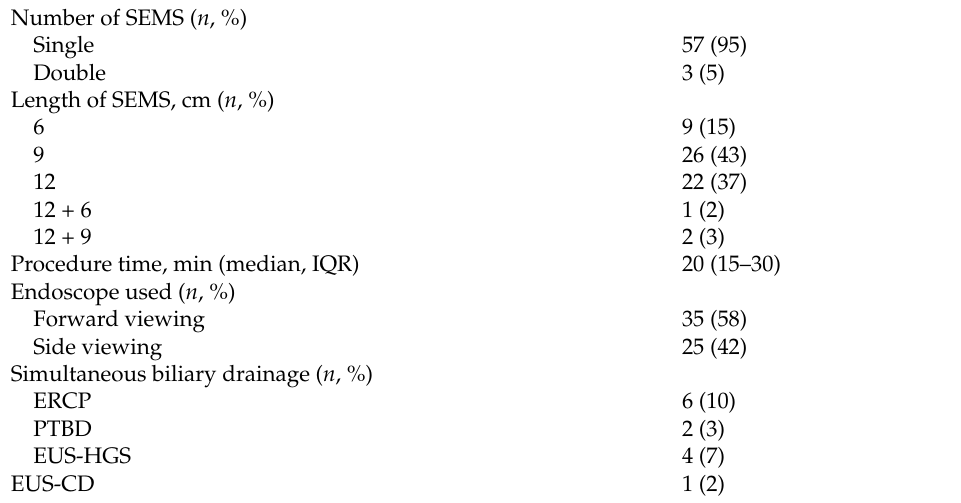
Table 2. Procedure of duodenal stenting.